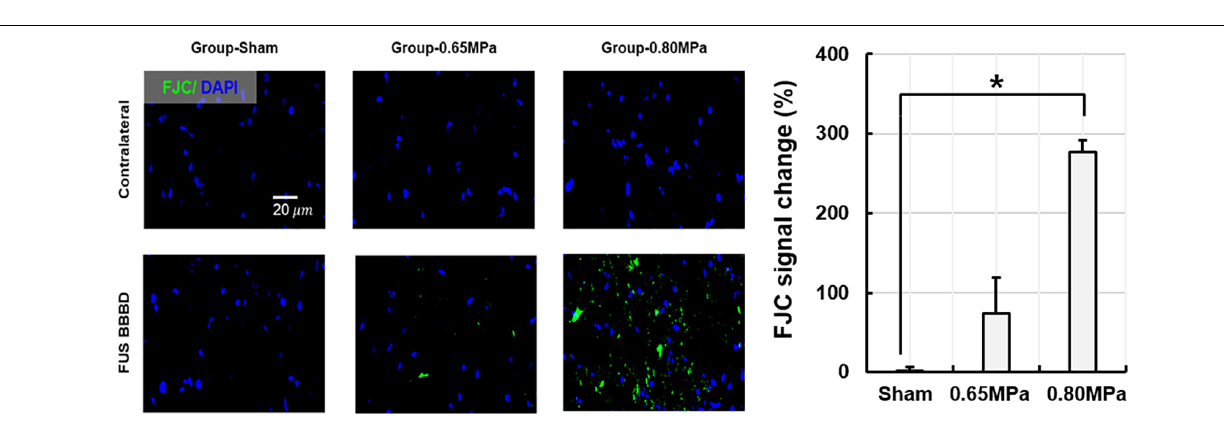
FIGURE 8 | Representative H&E histology at 48 h after the FUS–BBBD. The samples of group-0.65 MPa show no apparent tissue damage, while the samples of group-0.80 MPa show extravasation of red blood cells. Scale bar of H&E: 50 µ m.